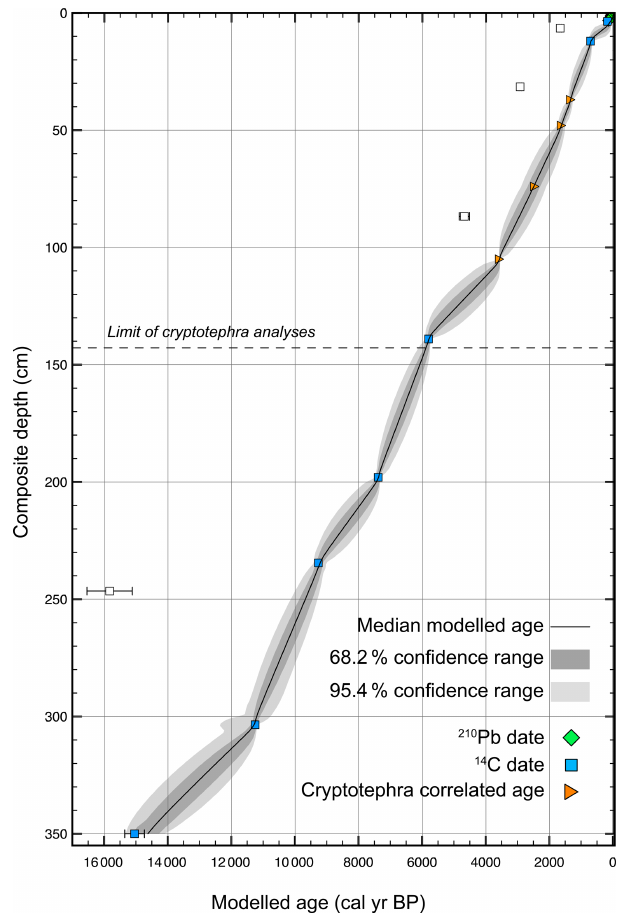
Figure 6. Age–depth plot showing the final Bayesian age model for Cascade Lake composite core CASC-4A/2D. Shaded areas show the 1 σ (68.2%) and 2 σ (95.4%) confidence ranges. Filled symbols are included in the model and white symbols are identified as out- liers. Two sigma errors are included for all ages; where they are not visible the error is smaller than the symbol used. Full details and values can be found in Table